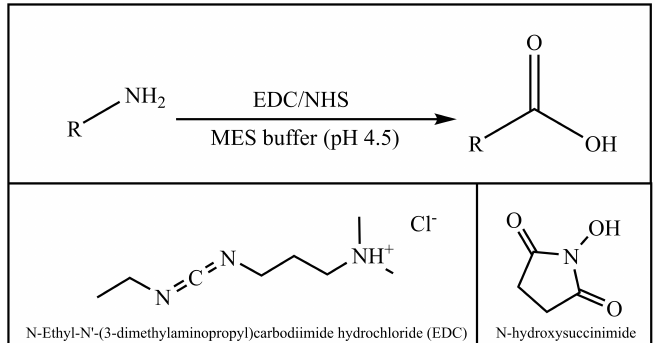
Figure 2. A generic reaction scheme showing the conversion of terminal amino groups into carboxylic acid groups that be used for functionalization using EDC and NHS.